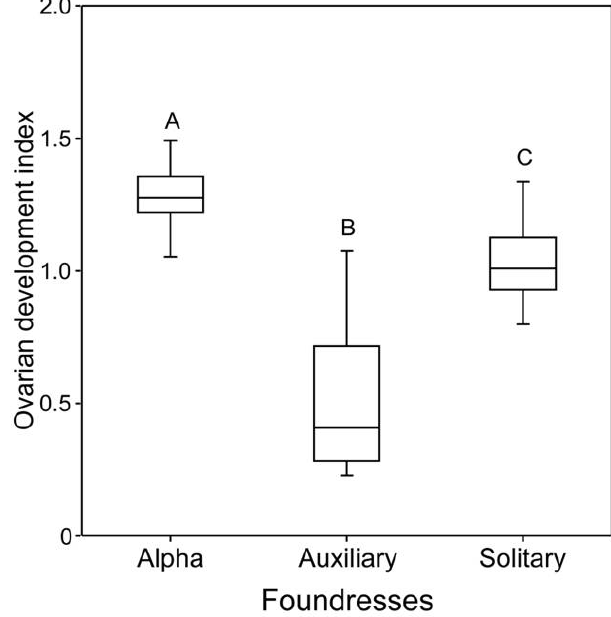
Fig 2. Variation in ovarian development index for foundresses of Mischocyttarus consimilis . Box-plot represents the median, 25% - 75% percentiles and minimum/maximum range. Different letters indicate statistical significance ( P <0.05).